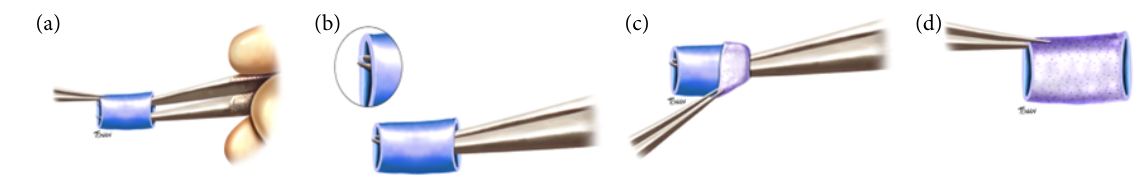
Figure 1 - Inversion of the vein graft process. (a) With the two tips catheterizing the lumen of the vein, the microsurgical titanium instrument (microsurgical forceps with angulated tips) was introduced all the way to the other end of the tubular structure (vein). (b) Clamping of one of the faces of the vein. (c) Reversing the vein inside out with the aid of an auxiliary microsurgical forceps with straight tips. (d) Result of the graft vein inversion process with the adventitia facing the lumen of the graft, and the endothelium facing the